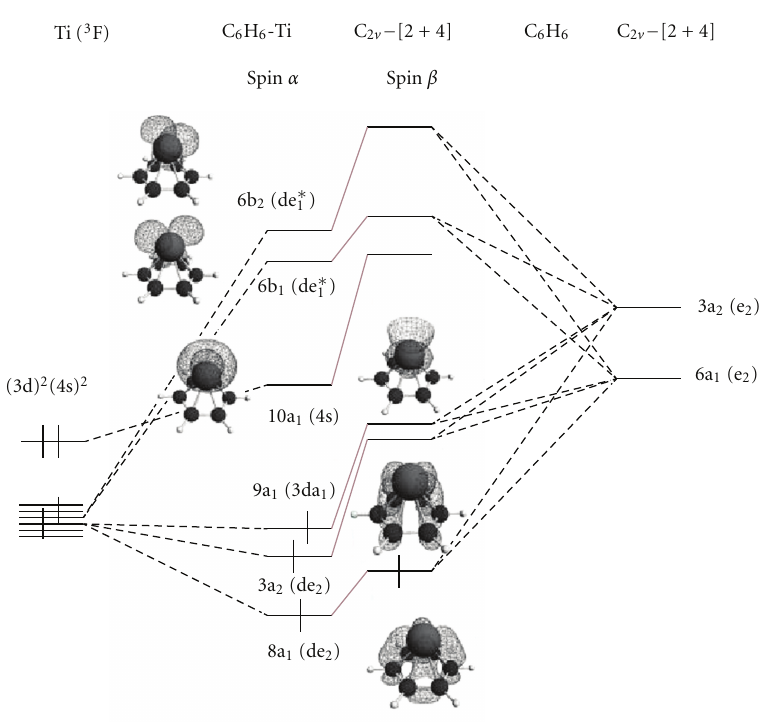
Figure 3: MO interaction diagram of the formation of C 6 H 6 Ti C 2 v – [2 + 4] from Ti and C 6 H 6 . In parentheses the parentage of the levels from those of C 6 v C 6 H 6 Ti (with planar C 6 H 6 ), see Figure 1. Hydrogen, carbon, and titanium atoms are shown in white, dark grey, and light grey, respectively.